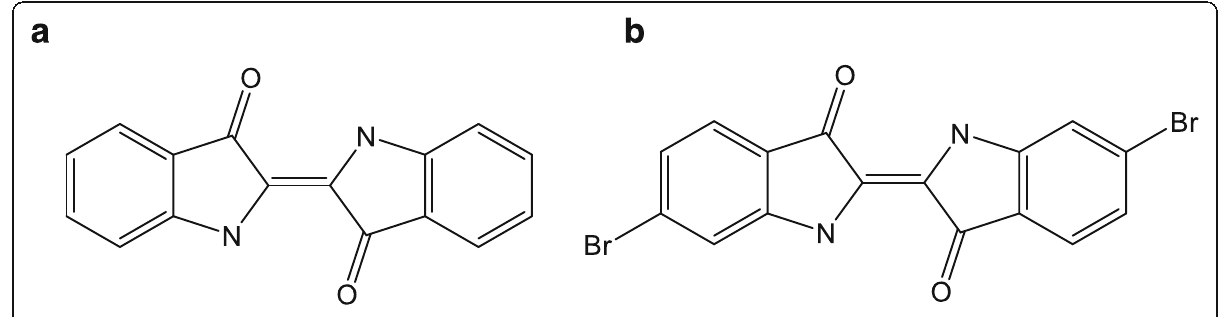
Fig. 1 The molecular structure of indigo ( a ) and its derivative (6,6 ′ -dibromoindigo) as Tyrian purple ( b